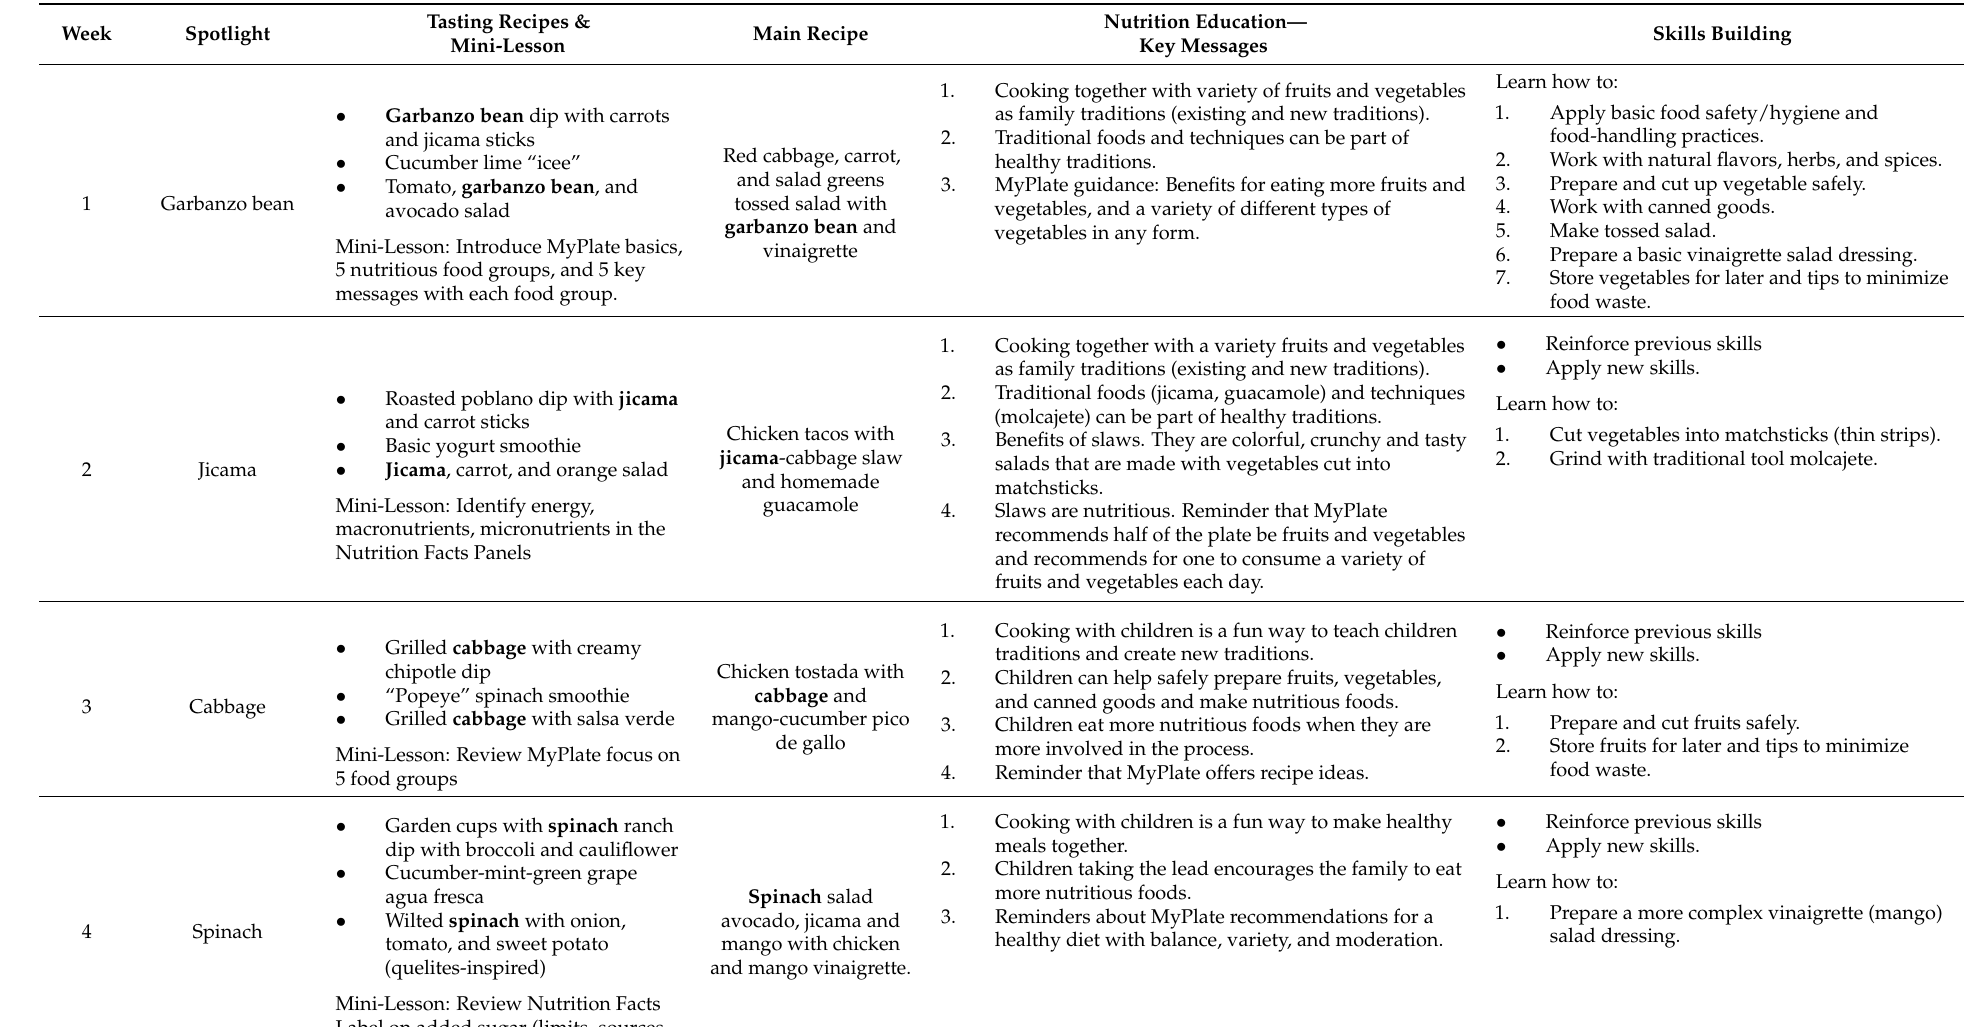
Table 3. Spotlights, tasting recipes, main recipes, nutrition education and skills building for the cooking